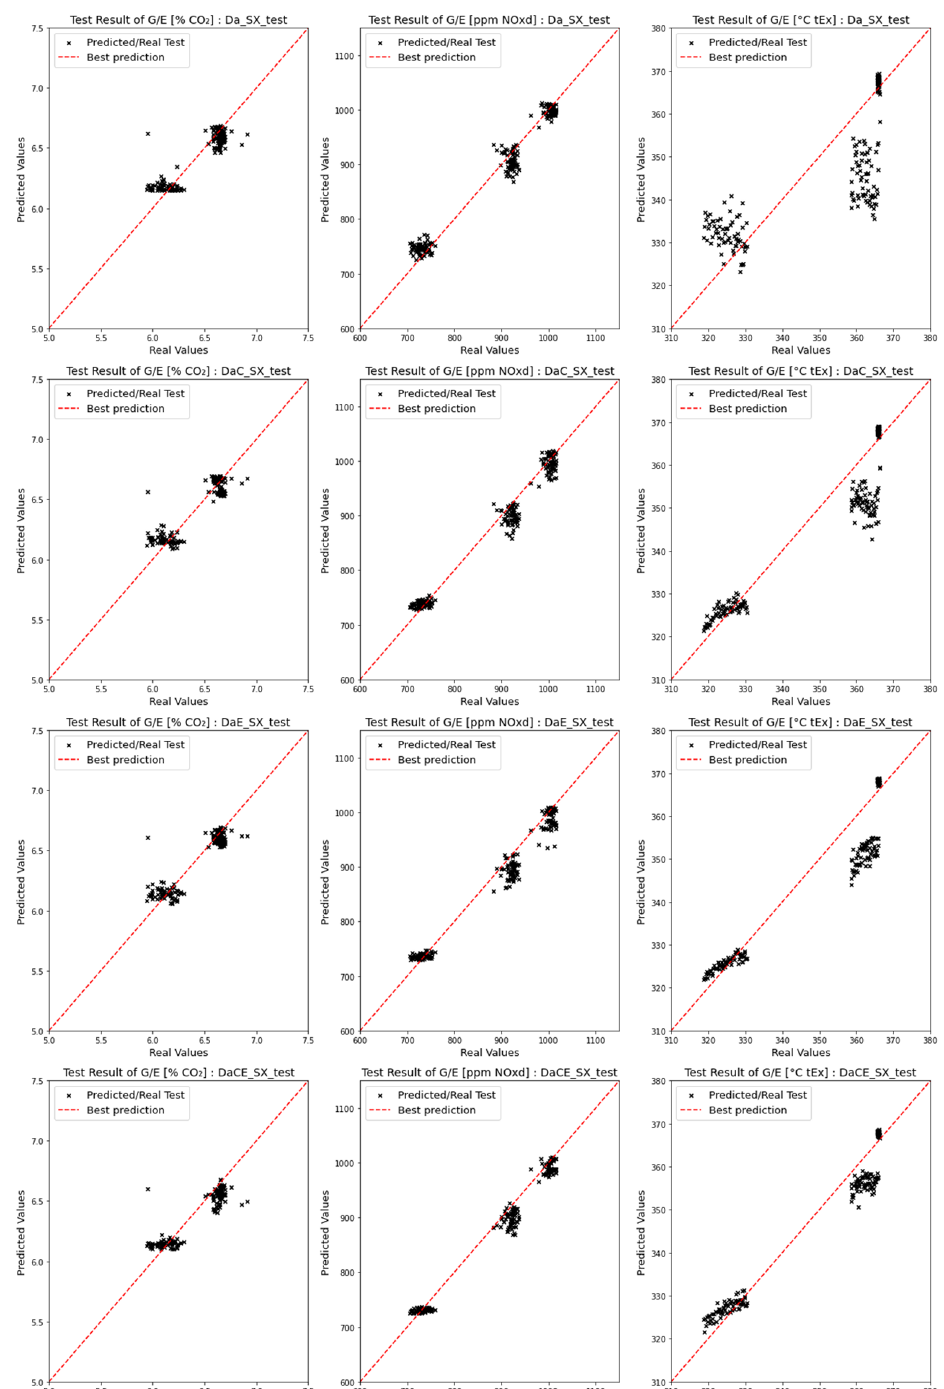
Figure 8. Comparison of dataset performances for ANN model with the no ‐ SCR mode.